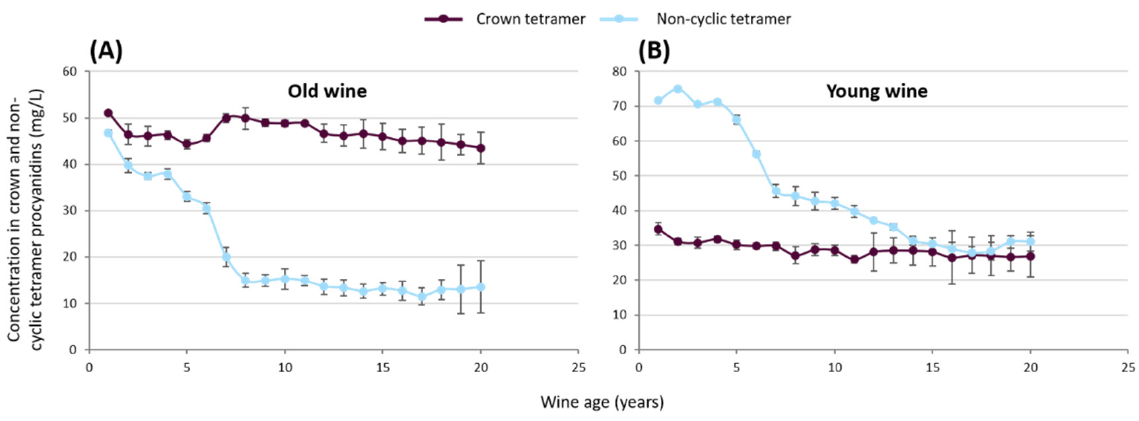
Figure 5. Evolution kinetics of crown and non-cyclic procyanidins’ tetramer in red wine under strong oxidative condition. ( A ) Old wine and ( B ) young wine.